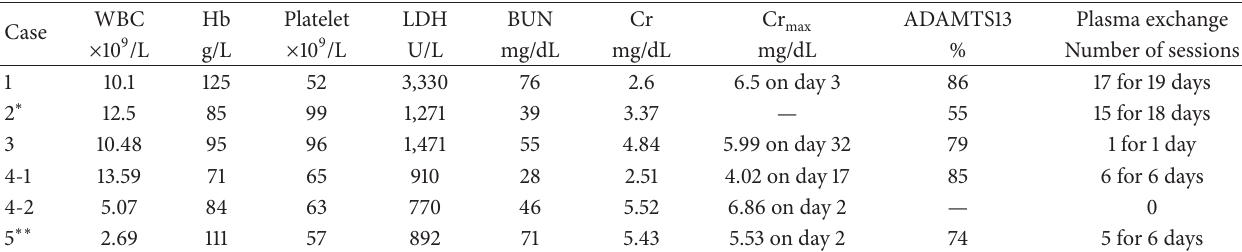
Table 2: Laboratory findings at presentation.